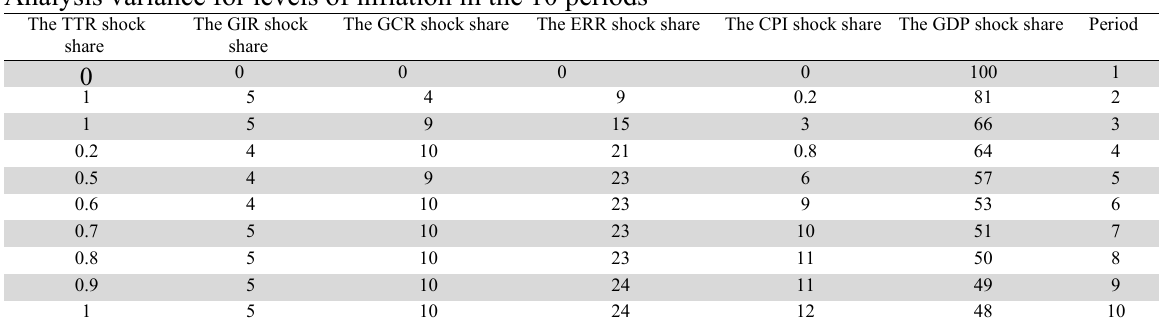
Analysis variance for levels of inflation in the 10